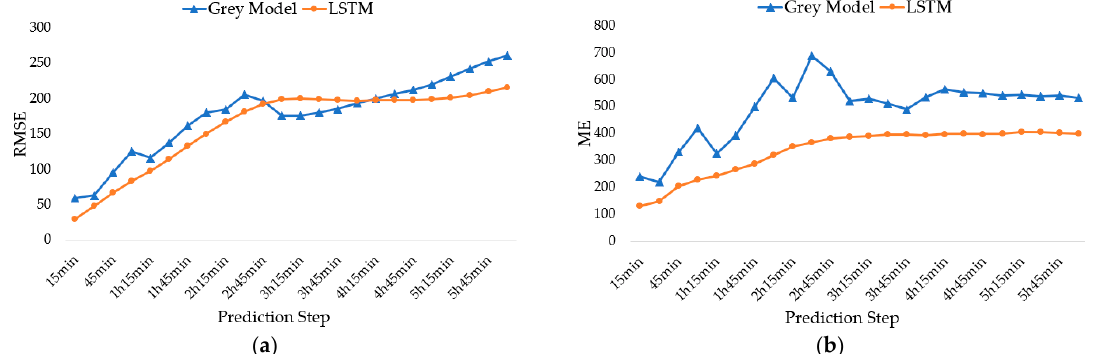
Figure 10. Prediction results of Grey model. Appl. Sci. 2019 , 9 , x FOR PEER REVIEW